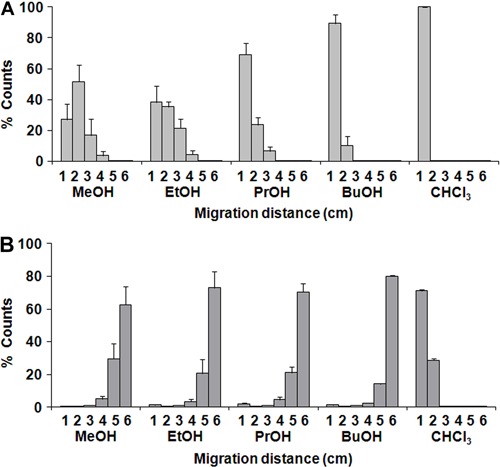
Paper chromatography of 99mTcO4
- (A) and
[99mTc(MIBI)6]+(B) reported
as percent of counts in segments of the chromatographic strip (cm), numbers 1 to
6. Alcohols (MeOH: methanol, EtOH: ethanol, PrOH: 1-propanol, BuOH: 1-butanol) or
chloroform (CHCl3) were used as the mobile phase, and Whatman 1 (W1)
paper as the stationary phase [a similar behavior was obtained with Whatman 3MM
(W3MM) paper, data not shown]. Data are reported as means±SD for n=3.